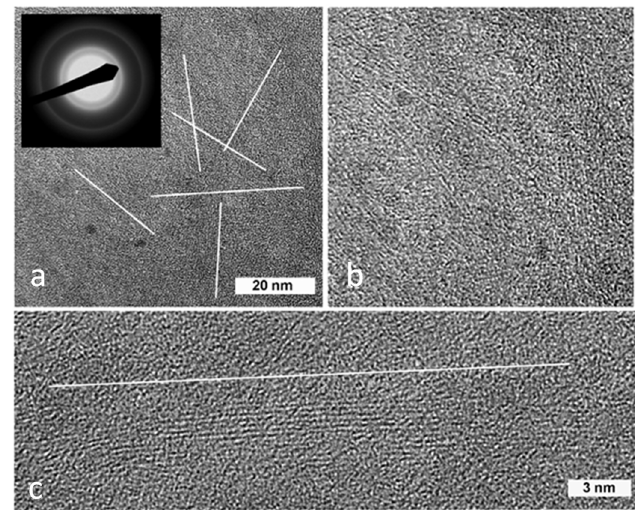
Figure 3. TEM images of the SWCNT analyzed sample with scale bar 20 nm ( a ) and 3 nm ( b ) and ( c ). The inset in ( a ) shows a representative SAED pattern with ring-shaped diffraction effects, due to randomly oriented nanocrystals.